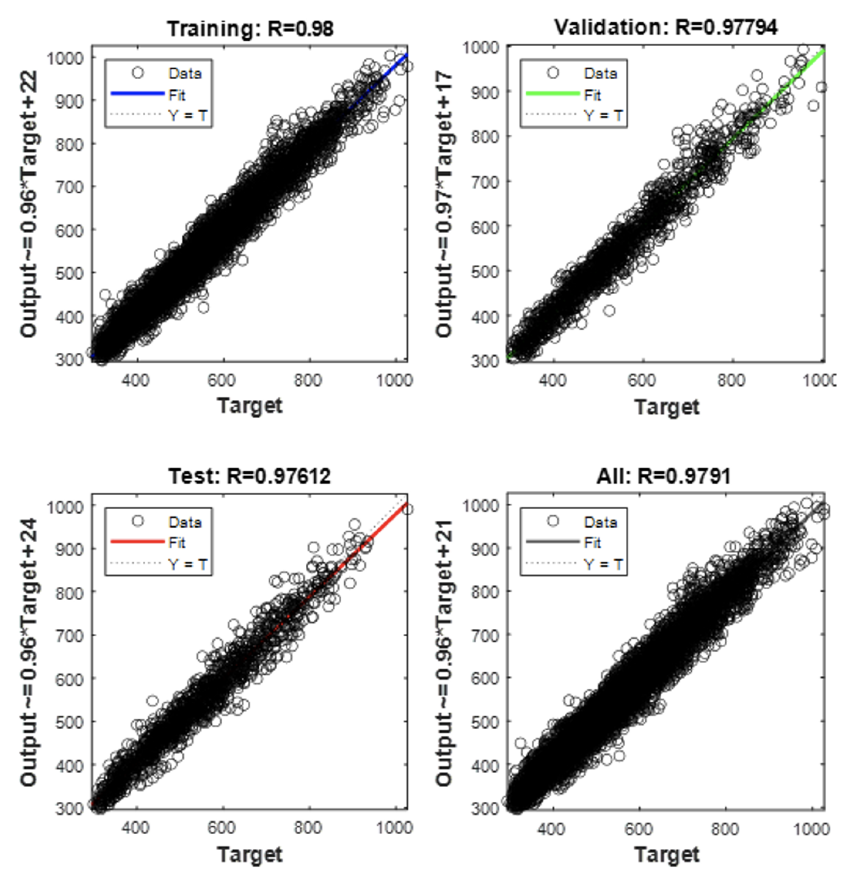
Figure 8. Performance of the trained model for load forecasting.